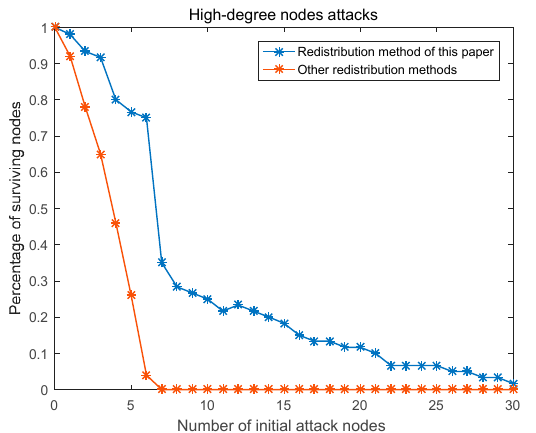
Figure 11. Comparison of survivability under different allocation methods.